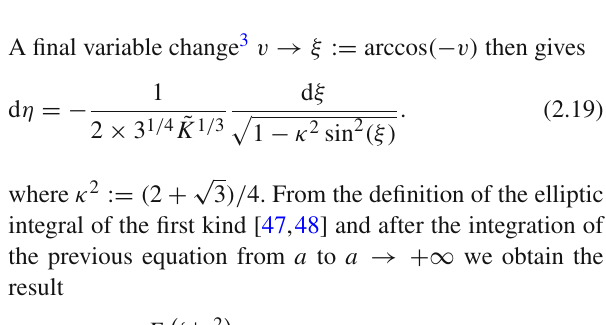
Fig. 1 The evolution of the scale factor as a function of the cosmic time (cf. Eq. (2.16)) and of the conformal time (cf. Eq. (2.21)). The moment of transition from decelerated expansion to inflation is indicated by a dark dot